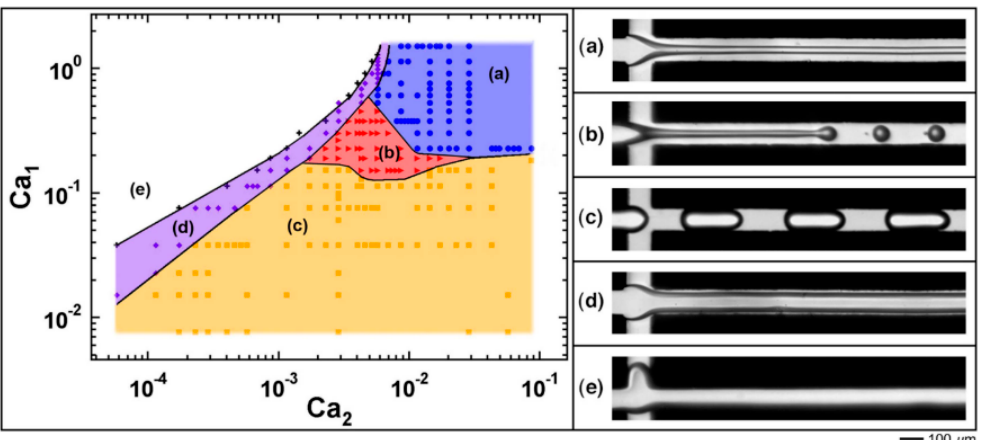
Figure 3. Capillary number-based flow patterns in a flow-focusing microchannel. Ca 1 and Ca 2 are the capillary numbers of the to-be-dispersed and continuous phases, respectively. The five flow patterns are: ( a ) Threading; ( b ) jetting; ( c ) dripping; ( d ) tubing; ( e ) and viscous displacement. Reprinted from Cubaud et al. (2008) [31], with the permission of AIP publishing.